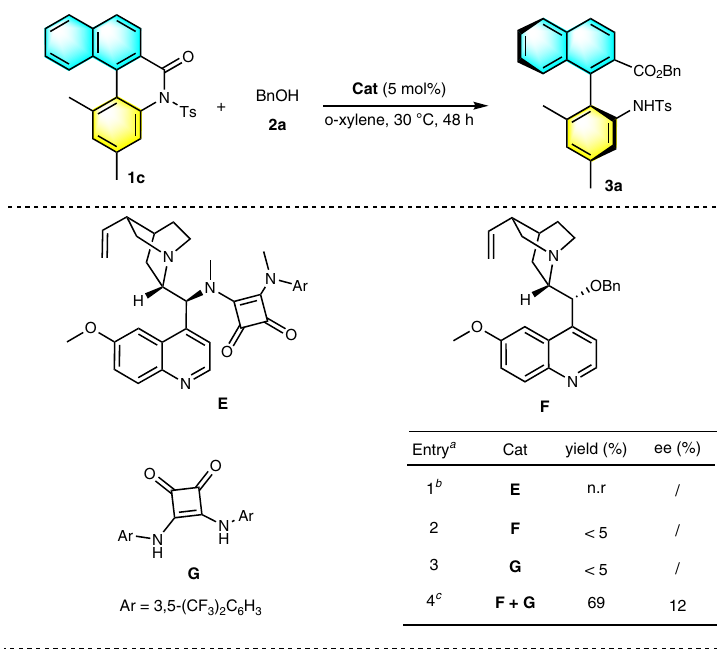
Fig. 2 Mechanism study. a Standard condition: 1c (0.1 mmol), BnOH (1.2 equiv.), catalyst (5 mol%), and o-xylene (0.2 M), rt, 48 h. b n.r = no reaction. c 5 mol% F and 5 mol% G were simultaneously added.